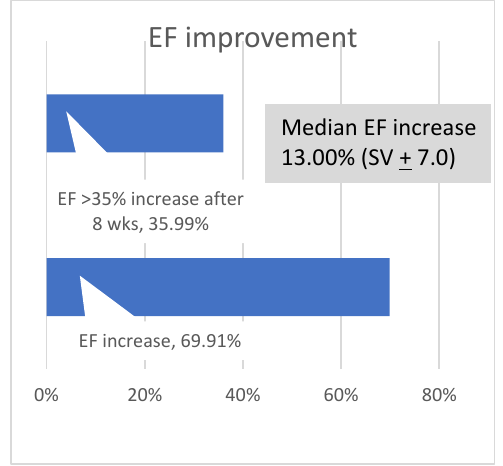
Figure 3. LV-EF improvement after 8 weeks.